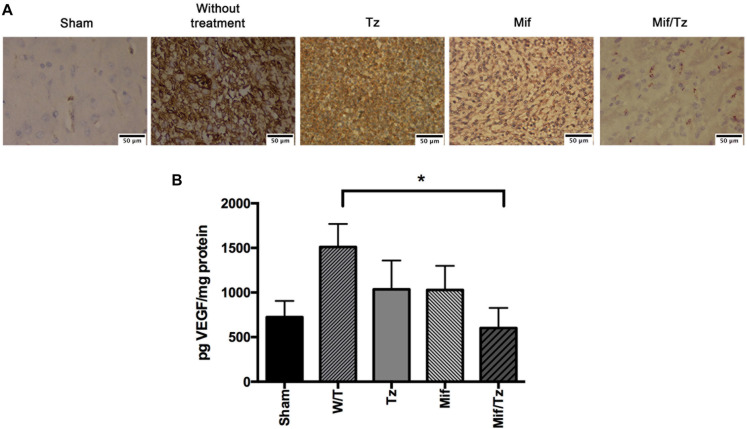
(A) Immunohistochemical staining of CD31 marker. Vessel density was assessed by immunostaining for CD31 positive glioma cell nuclei in rats implanted with glioma. The images are representative of three animals per treatment. Scale bar 50 μm. (B) Expression of VEGF at the end of the 3-week drug treatment, showing a significantly lower level in the mifepristone/temozolomide (Mif/Tz)-treated group versus the untreated (W/T) group, both with implanted cancer cells. Data are expressed as the mean ± SD from eight independent experiments. *Significant difference (p < 0.05) between the Mif/Tz and W/T group.